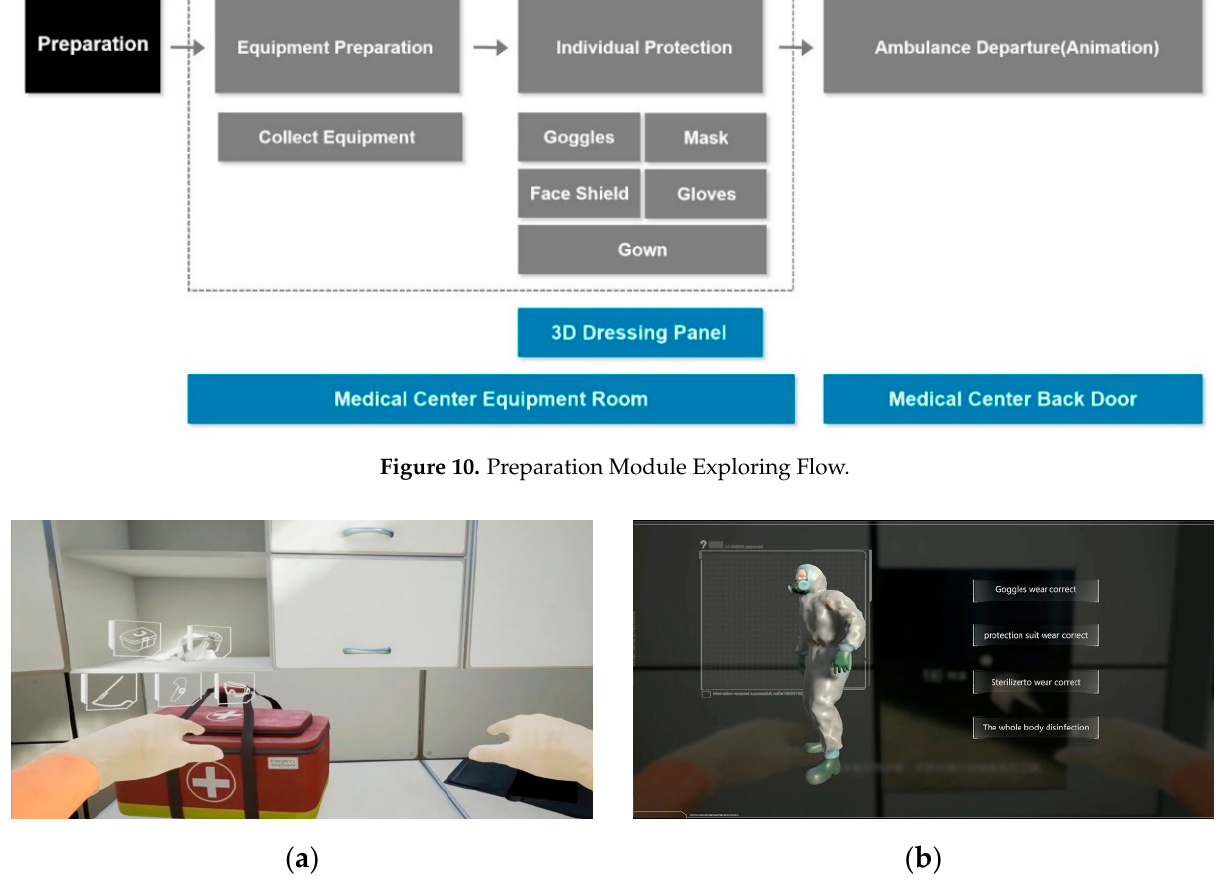
Figure 11. Preparation Module Implementation: ( a ) Equipment Preparation [9]; ( b ) Individual Protection Dressing 3D UI Panel [9].